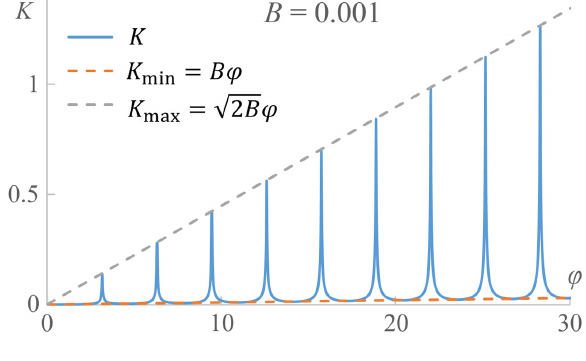
FIG. 17. K ð φ Þ dependency at B ¼ 0 . 001